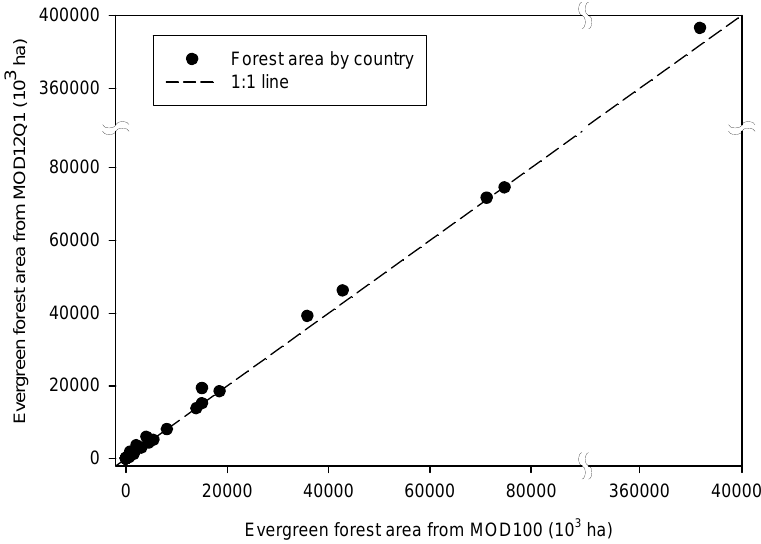
Figure 3. A country-level comparison for the area estimates of evergreen forests in tropical America (30 ° N–30 ° S) between the LSWI-based algorithm in this study (MOD100) and the standard MODIS Land Cover Product (MOD12Q1) in